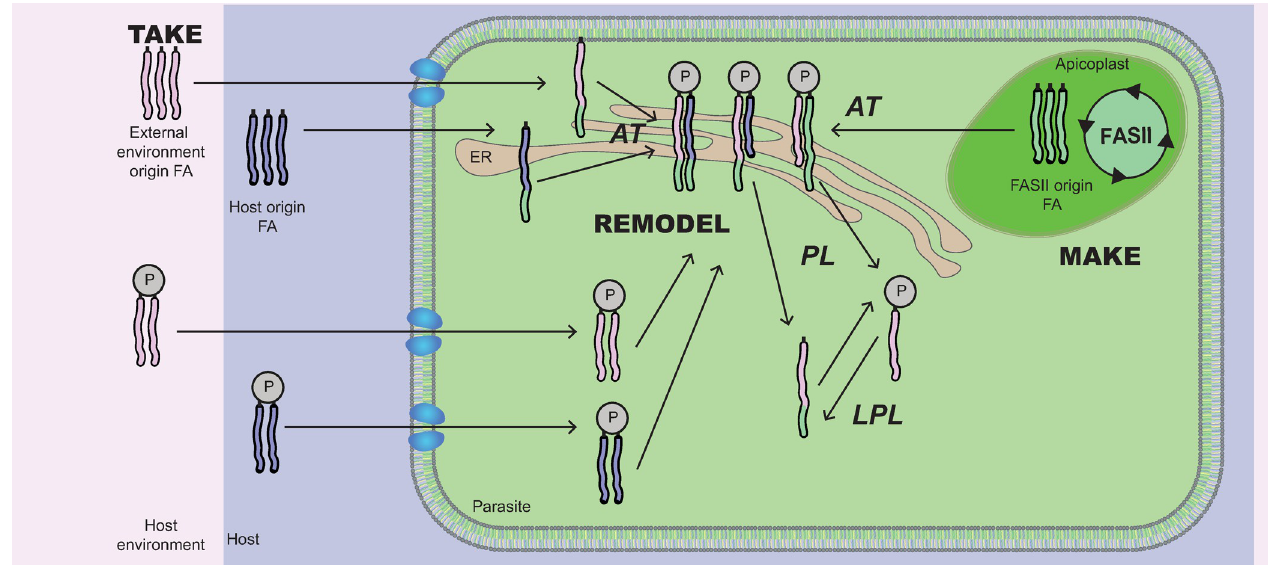
Fig 1. “Make, take, and remodel”; the central dogma explaining how the parasite is able to scavenge lipids from the host environment, the host itself (“Take”) while also synthesize them de novo (“make”). FA elongation and a patchwork assembly mechanism in the ER contribute further to glycerolipid metabolism in the parasite (“remodel”). AT AU : AbbreviationlistshavebeencompiledforthoseusedinFigs 1 (cid:0) 4 : Pleaseverifythatallentriesarecorrect : , acyltransferase; FA, fatty acid; LPL, lysophospholipase; PL,